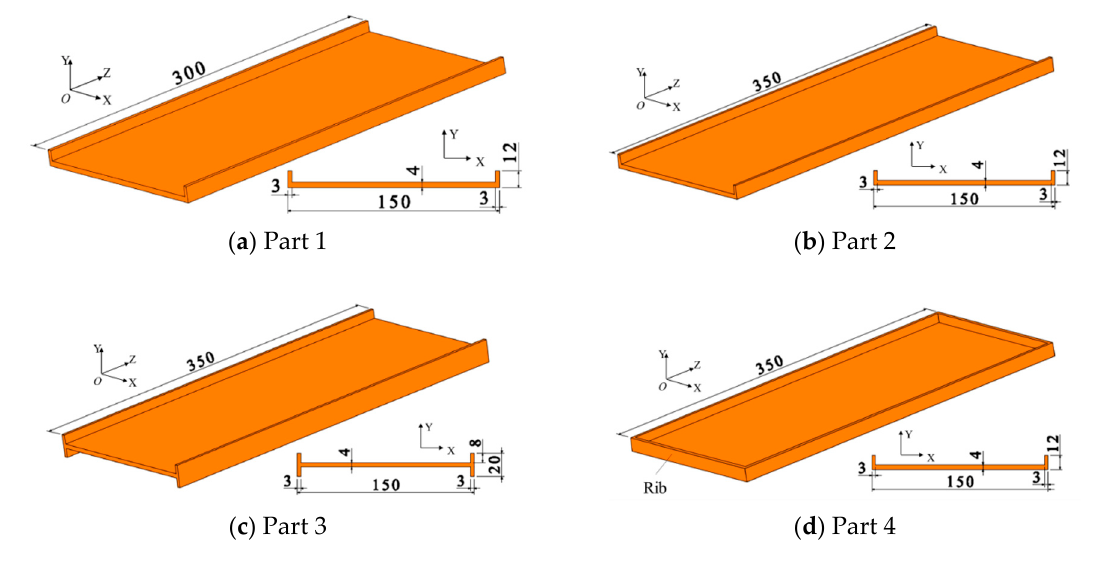
Figure 3. The part shape (unit = mm). Table 1. Mechanical properties of AA6061-T651.